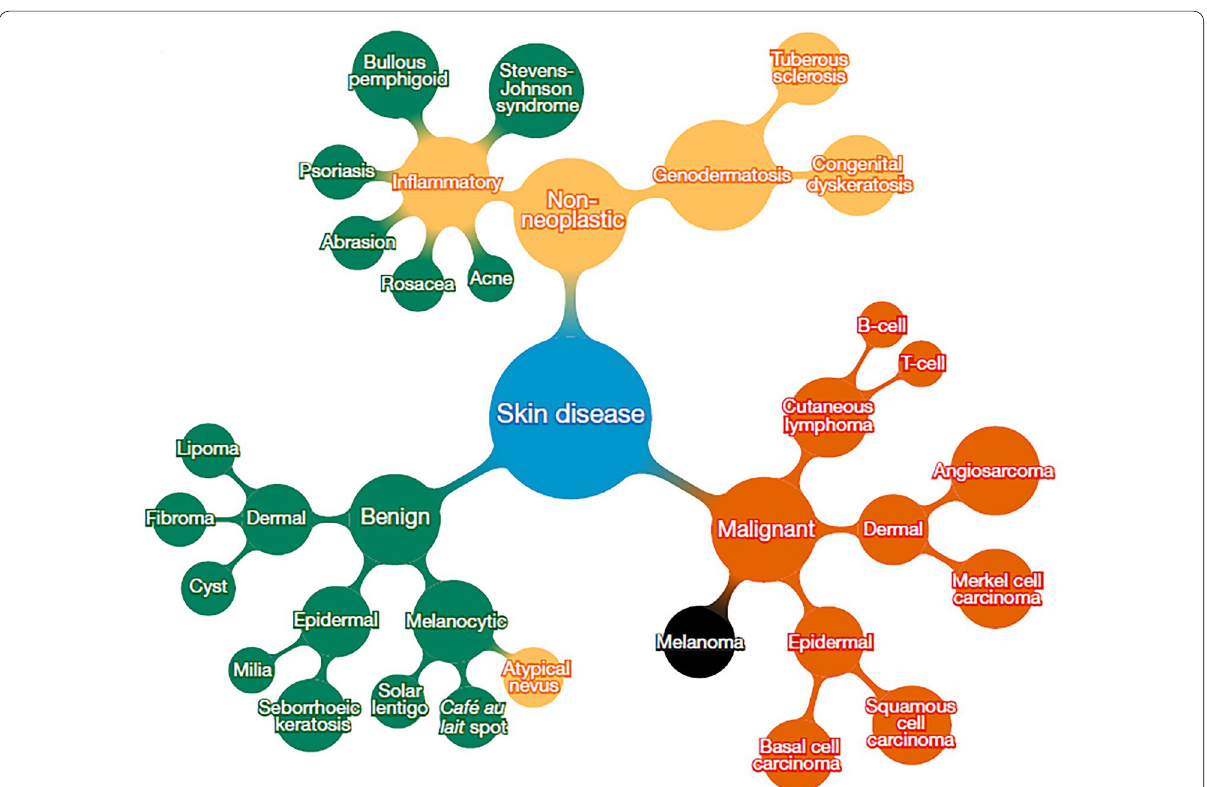
Figure 1 Subset of top of tree-structured taxonomy of skin disease ( Reproduced with permission from Ref. [9] and credit (CC BY